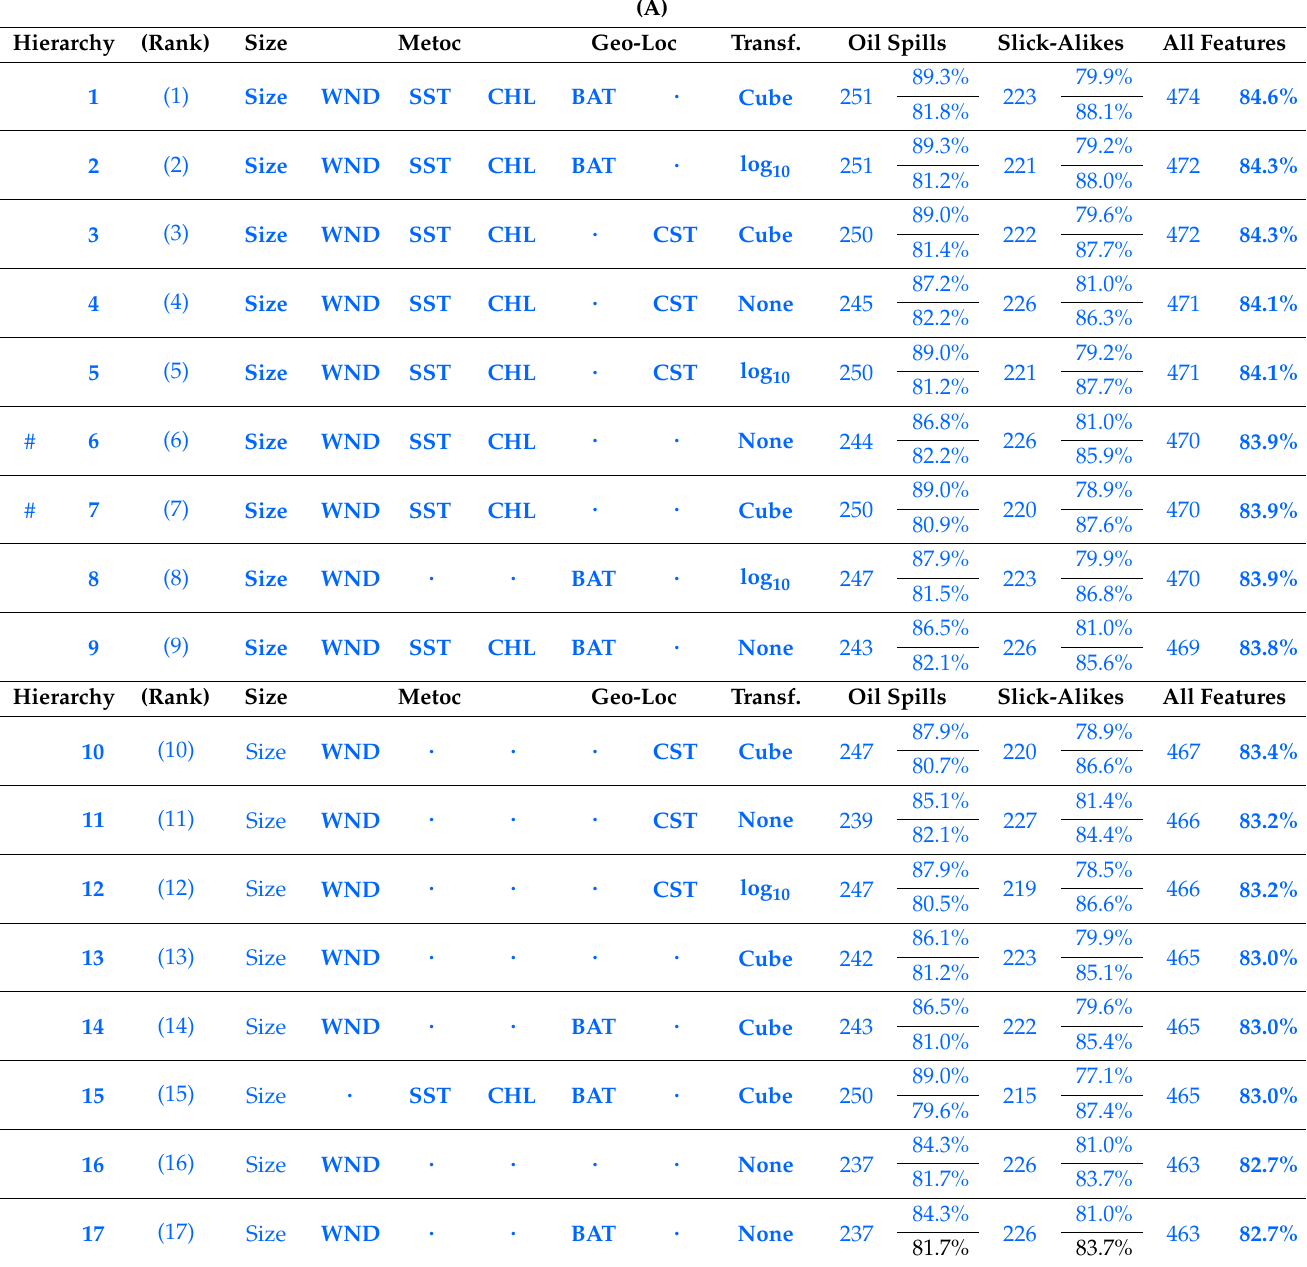
Table 3. Classification accuracy from testing 60 LDA algorithms to determine the best combination of variables—first objective, i.e., “Data-Information Experiment”. Inclusive hierarchy runs from 1 to 60 and is divided in three color-coded blocks: (A) Size Plus Metoc Set (blue: 1–29) (B) Size Set (green: 25–36) and Metoc Set (gray: 37–60), all of which were analyzed with or without at least one geo-location parameter and were subjected to the same data transformation (Transf.): none, cube root, or log 10 . A ranking within attribute-type subdivisions is also provided between parentheses: 1–27 (Size Plus Metoc Set: blue), 1–9 (Size Set: green), and 1–24 (Metoc Set: gray). Blocks match the three attribute-type subdivisions (Figure 3). Size information: area, compact index (CMP: (4. π .area)/(perimeter 2 )), aspect ratio (length-to-width ratio: LtoW), perimeter-to-area ratio (PtoA), fractal index (FRA: 2.ln(perimeter/4)/ln(area)), and number of parts of each feature (NUM). Meteorological-Oceanographic (metoc) variables: wind speed (WND), sea surface temperature (SST), and chlorophyll-a concentration (CHL). Geo-location (geo-loc) parameters: bathymetry (BAT) and distance to coastline (CST). Variables not used are indicated with a dot. # indicates combinations previously investigated [42]. $ indicates hierarchies out of order. * indicates unbalanced identification rate: algorithms correctly identifying 30% or more oil spills than look-alike slicks. ! indicates void algorithms: at least one performance metric below 60%, i.e., specificity. For the interpretation of thick table lines see Section 4.2. Detailed statistical information is found in Figure